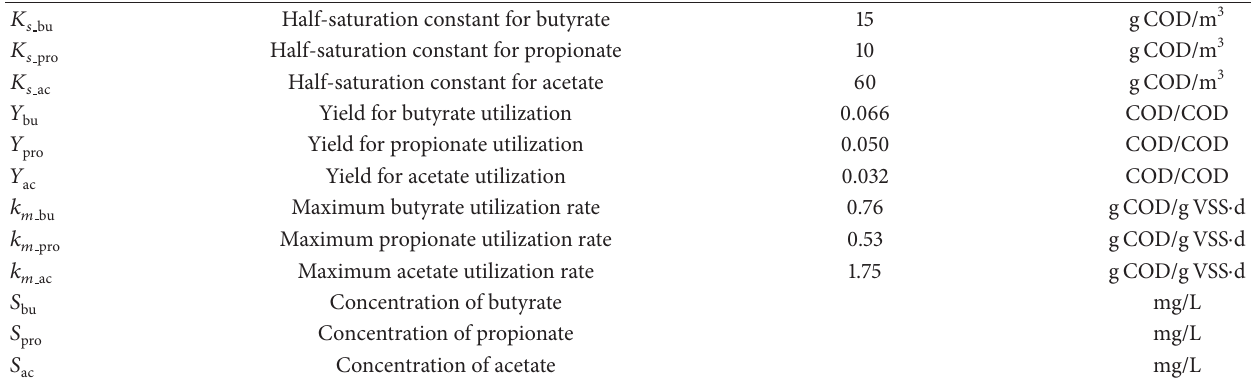
Table 2: The parameters applied in the biokinetic models (26 ∘